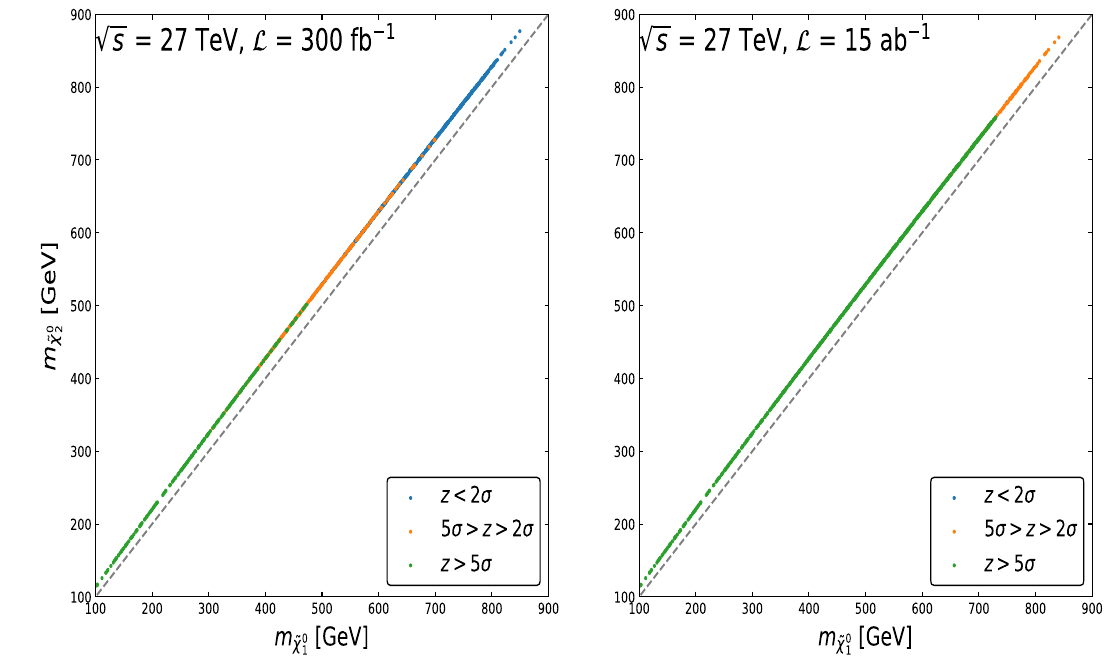
˜ χ 0 → (cid:9) + (cid:9) − + E miss + jets T 1 2